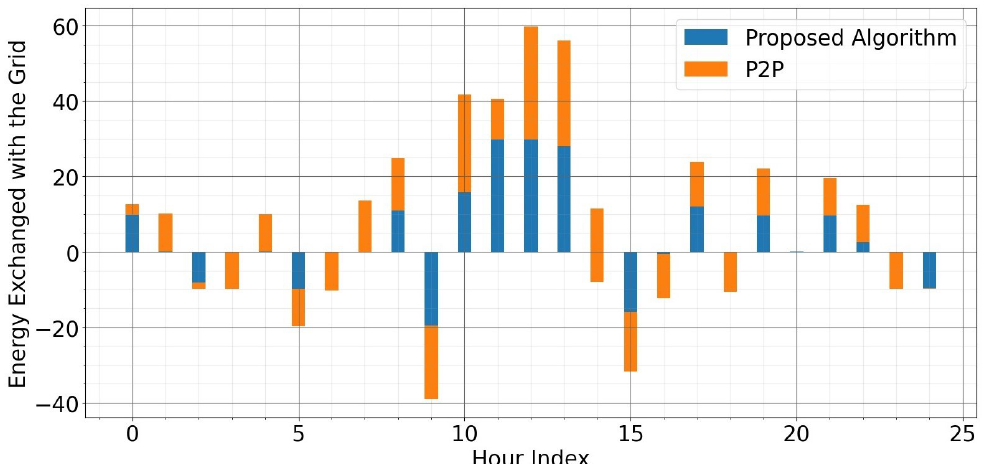
Figure 10. Energy exchange with the external